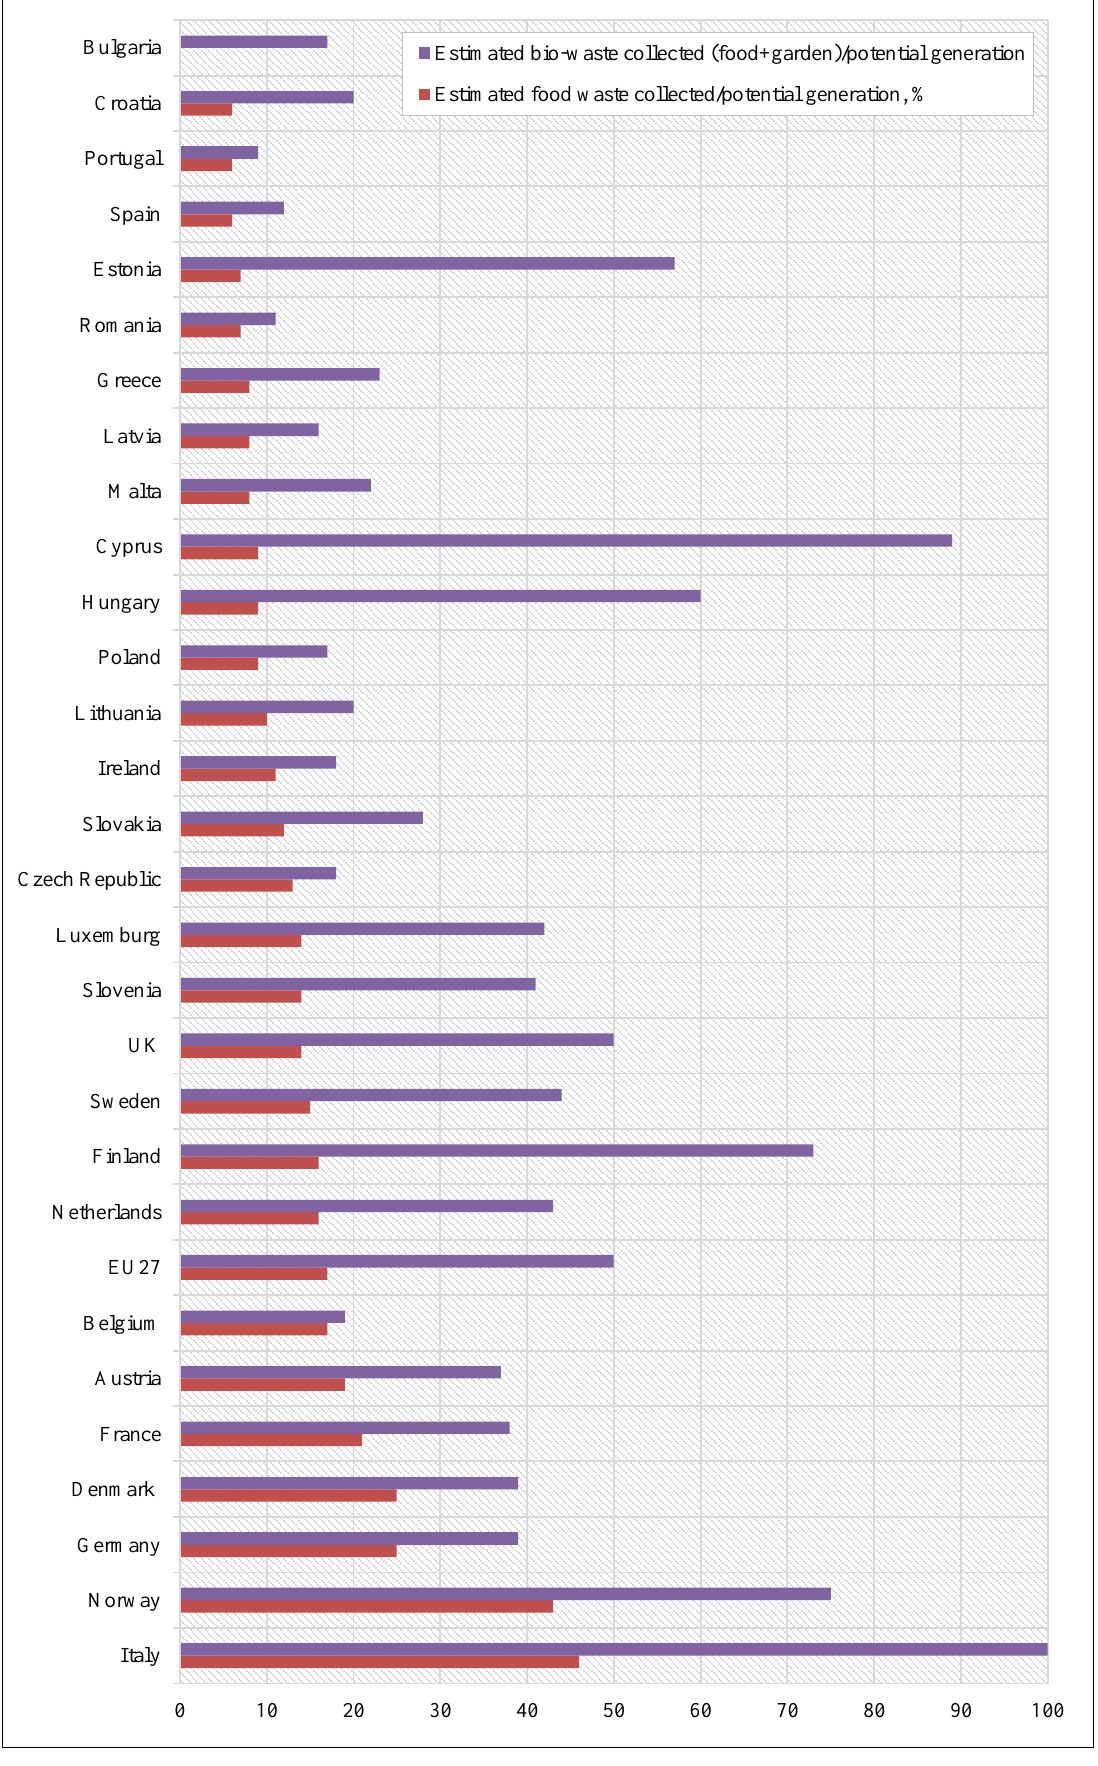
Figure 3. Comparison of theoretical potential vs. currently collected food waste and